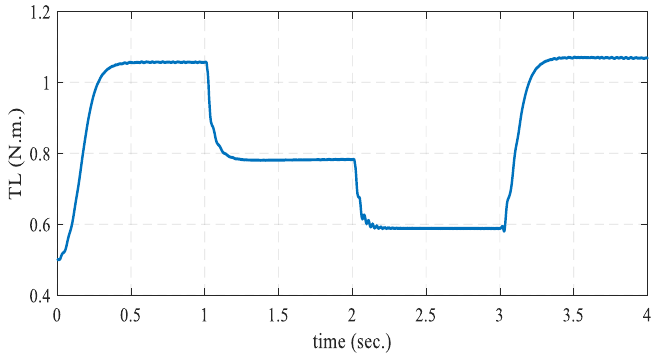
Figure 7. Pump torque–time characteristics with PID.